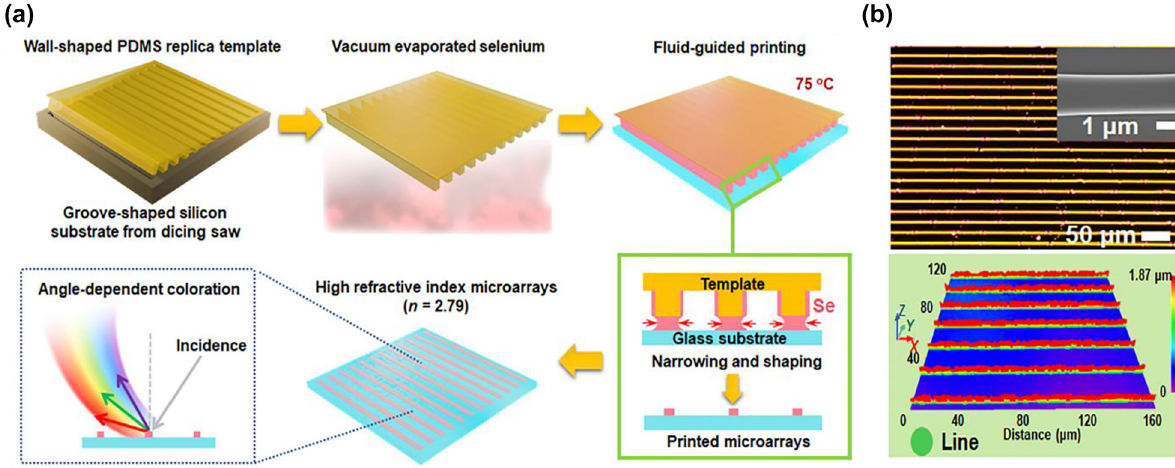
Figure 25: Fluid-guided printing for fabricating subwavelength nanostructure array based structural colors. (a) Schematic illustration of the fluid-guided printing process for preparing selenium microarrays. The fabricated device exhibits an angle-dependent coloration appearance. (b) Top panel: dark-field optical microscope image of the Se microline arrays. Inset: the associated SEM image. Bottom panel: 3D optical profile image of a fabricated sample. Modified with permission [259]. Copyright 2021,